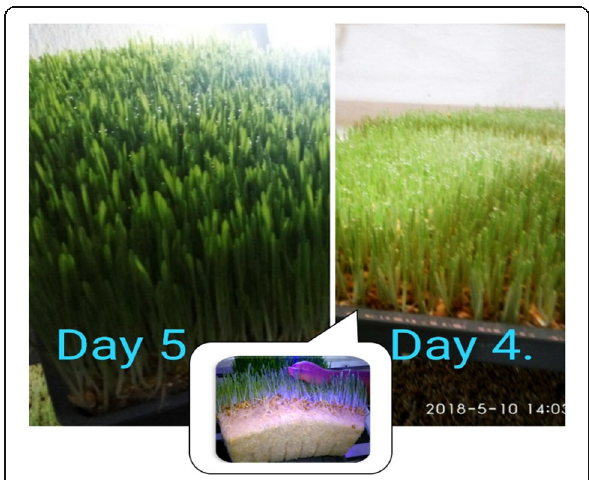
Fig. 8 High productivity of Russian barely plant by using endophytic T. harzianum bio-fertilizer through the intelligent hydroponic